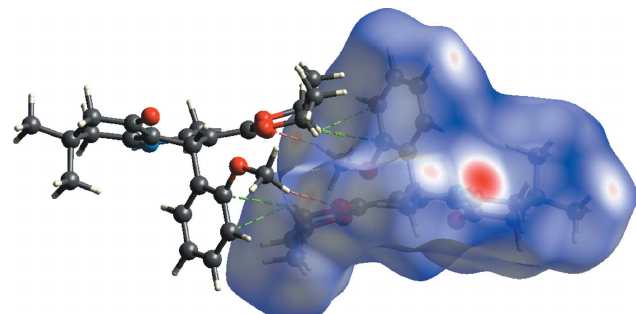
Figure 7 Hirshfeld surface of I mapped over d norm . Short and long contacts are indicated as red and blue regions, respectively. Contacts with distances approximately equal to the sum of the van der Waals radii are colored white. A (cid:3) - (cid:4) interaction between C15—H15 and phenyl ring is shown as green dashed lines. Hydrogen bond C23—H23 A (cid:5)(cid:5)(cid:5) O2 is shown as red dashed lines.